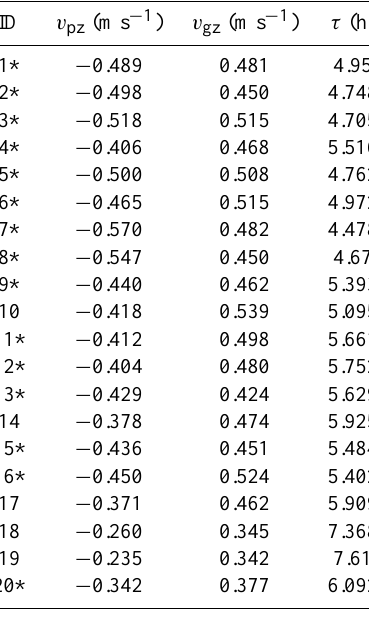
(cid:12) (cid:12)(cid:0) (cid:12) (cid:12) (cid:12)(cid:0) (cid:12) v gz − ˜ v gz (cid:1)(cid:14) v gz v pz − ˜ v pz (cid:1)(cid:14) v pz (cid:12) < 0 . 15 and (cid:12) < 0 . 15. EG